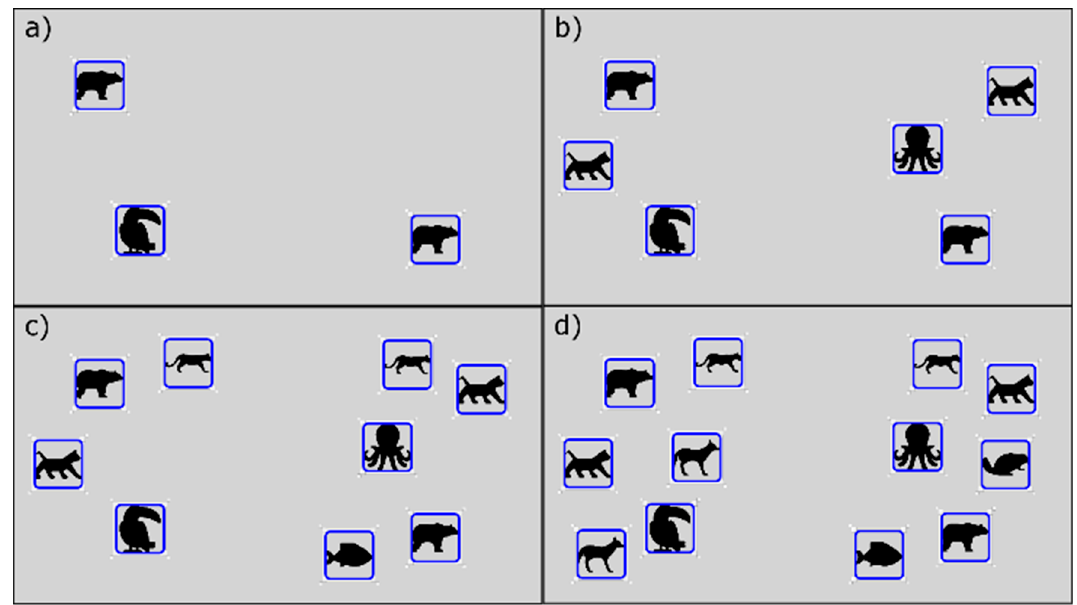
Figure 4. Levels of difficulty in step 2 of the example exercise.